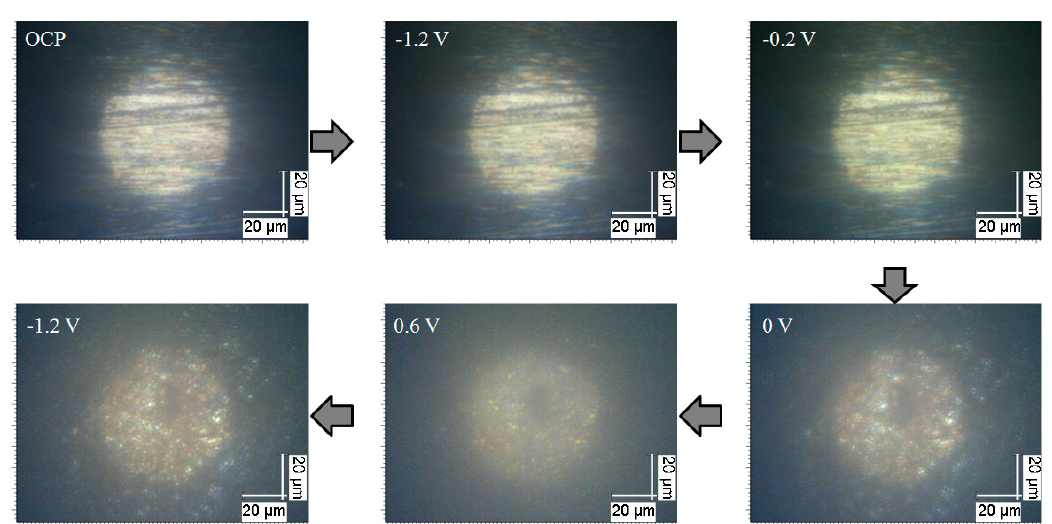
Figure 3. Stationary cyclic voltammograms after at least three cycles of copper electrode in neutral 3.5% (wt.) NaCl solution at room temperature. 3.2. Real-Time Raman Spectra at OCP The original in-situ Raman spectra and fitted Gaussian components from the copper electrode surface in NaCl solution during the initial 12 h are shown in Figure 4. When copper was initially immersed into the electrolyte, its Raman spectrum the exhibited weak characteristic peaks of Cu-Cl vibration arising from adsorbed Cl (cid:2879) on a copper surface as shown in the graph of 5 min from Figure 4. The relatively stronger band of Cu-O and Cu-OH vibrations is due to oxides resulting from the preparation of specimen in air. Then, CuCl and CuCl 2 (cid:2879) were formed and their characteristic peaks got more pronounced during immersion from 5 to 15 min. The spectra of 25 and 30 min showed pronounced features of oxides, because at those moments the laser was focus somewhere the OH (cid:2879) are preferentially adsorbed, such as on the terraces. However, chlorides were generated universally during this period and their features got more and more pronounced with the immersion time going up to 60 min. During the 2nd h of immersion, the experimental spectra changed very little and the features of the chlorides remained much stronger than those of oxides until an immersion time approaching 110 min. After an immersion time beyond 110 min, the features of CuCl and CuCl 2 (cid:2879)